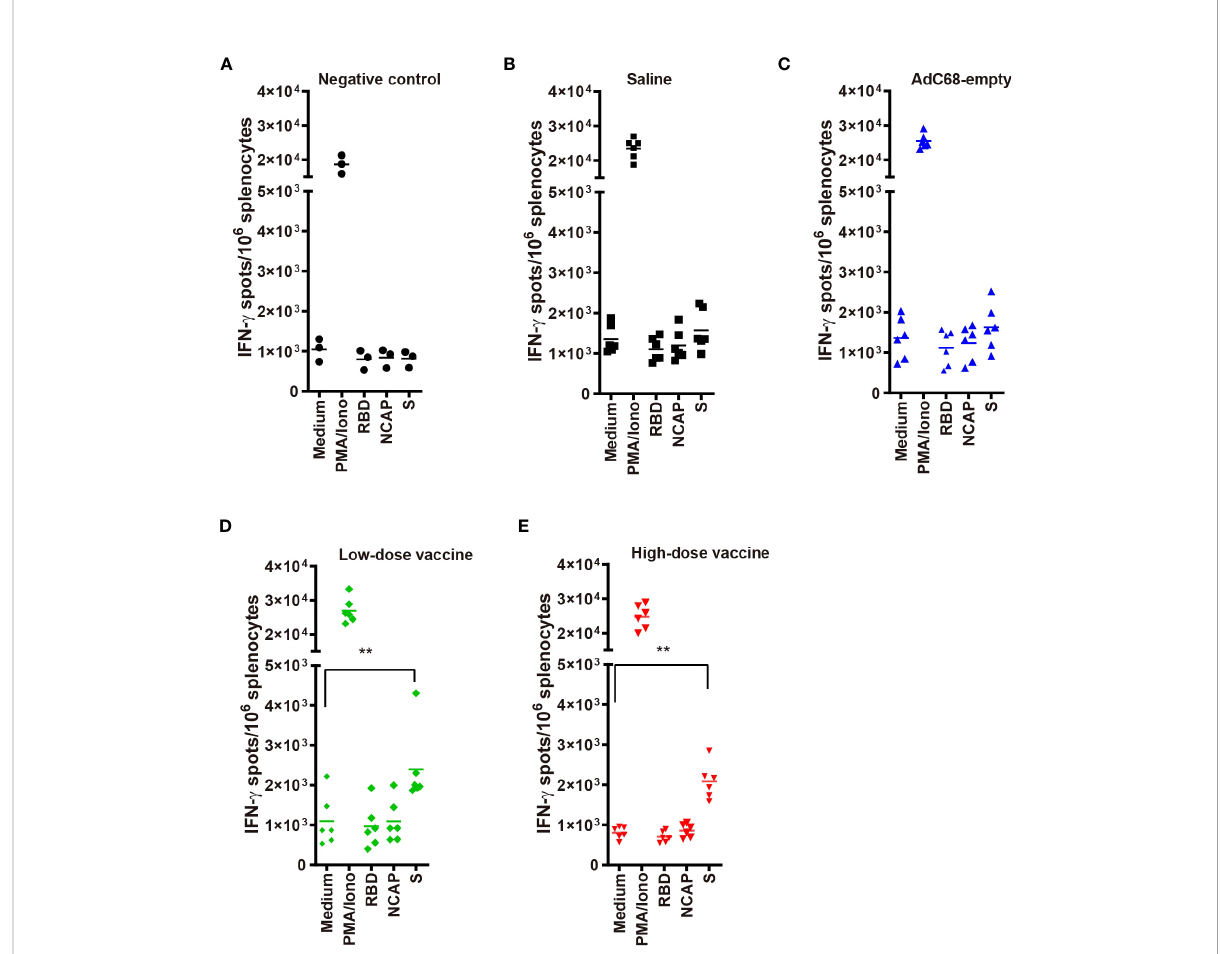
FIGURE 4 (A – E) IFN- g ELISpots in golden Syrian hamsters ’ splenocytes re-stimulated with: medium-only (negative control); PMA and ionomycin (positive control); and peptide pools from RBD, nucleocapsid (N) and spike (S). T-cell responses against SARS-CoV-2 antigens were evaluated using a hamster ELISpot IFN- g kit at dpi 7.